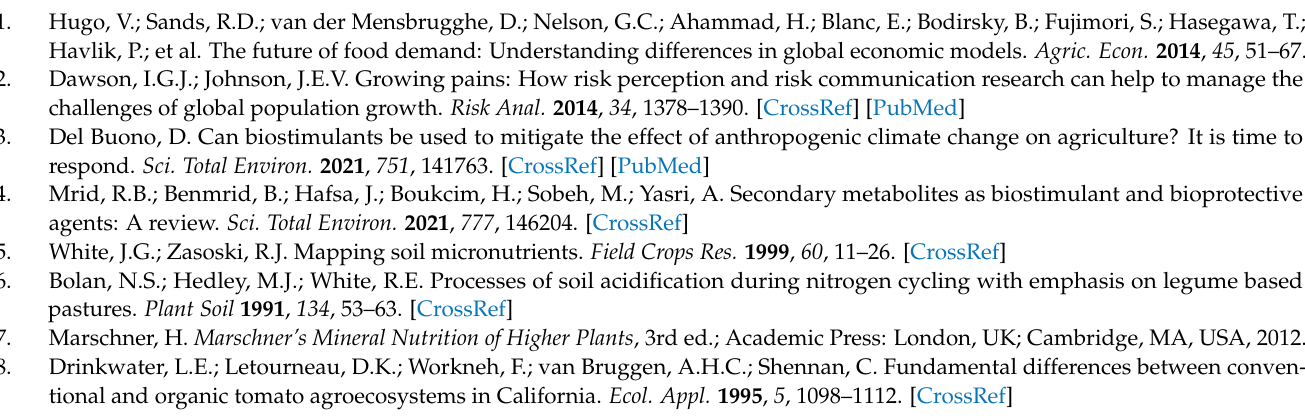
treatment, Table S2: Final nutrient concentrations in modified Hoagland’s nutrient solution, Figure S1: Set up and growth of the wheat cultivation vessel experiment to measure uptake and toxicity of metal chlorides and metal lactates, Figure S2: Representative dose response of 16-day old wheat ( Triticum aestivum ) plants to zinc chloride (ZnCl 2 ) and zinc